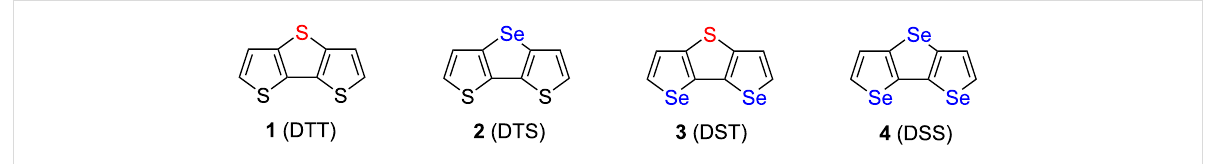
Figure 1: Heterotriacenes DTT 1 , DTS 2 , DST 3 , and DSS 4 with varying number of selenium atoms and fused selenophene